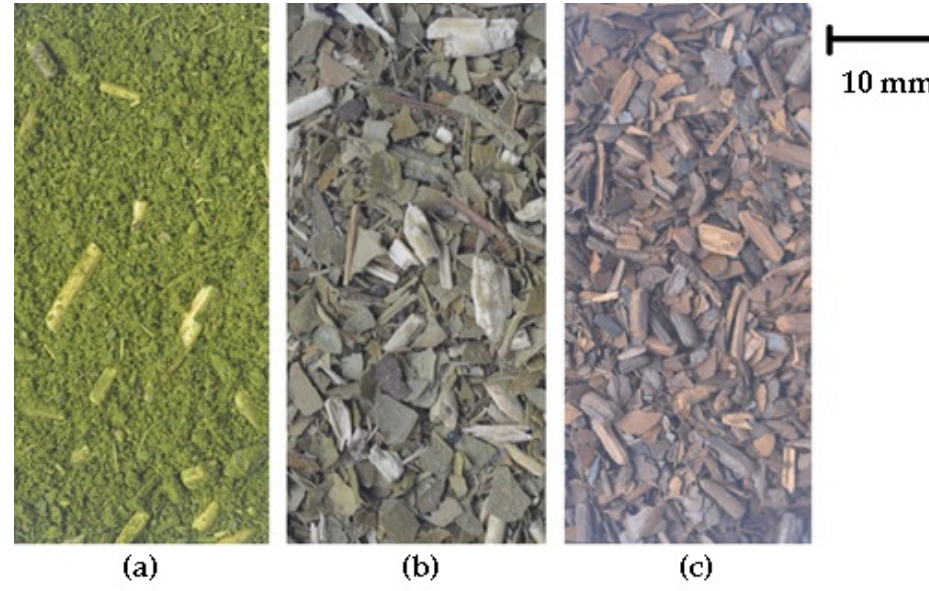
Figure 1. Some different mate tea types: ( a ) Brazilian typical standard (Brazilian chimarrão ); ( b ) Argentinean typical standard; ( c ) Roasted mate (known as ‘ chá-mate ’, in Brazil).